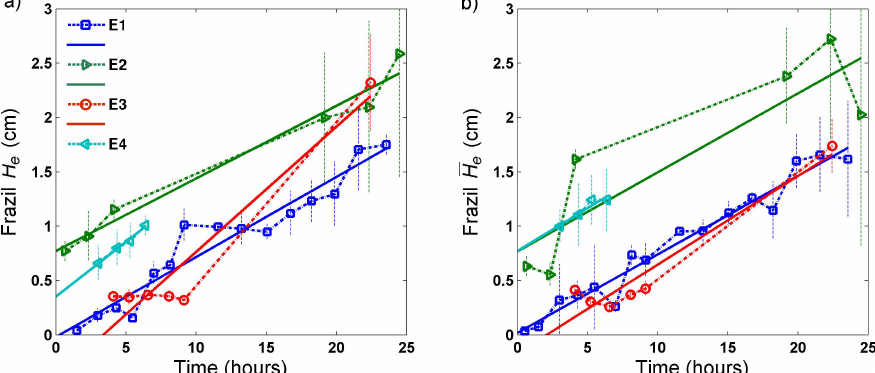
Fig. 7. Mean equivalent ice thickness H e spatially averaged over the tank (thick dashed lines) and corresponding linear regressions to estimate Q i (thick solid lines). Panel (a) corresponds to tank A, panel (b) to tank B. Thin vertical lines indicate the standard error of the mean, estimated from the difference of the measured and fitted ice thickness (shown in Fig. 3) times the thickness-weighted mean volume fraction (shown in Fig. 5c,d).